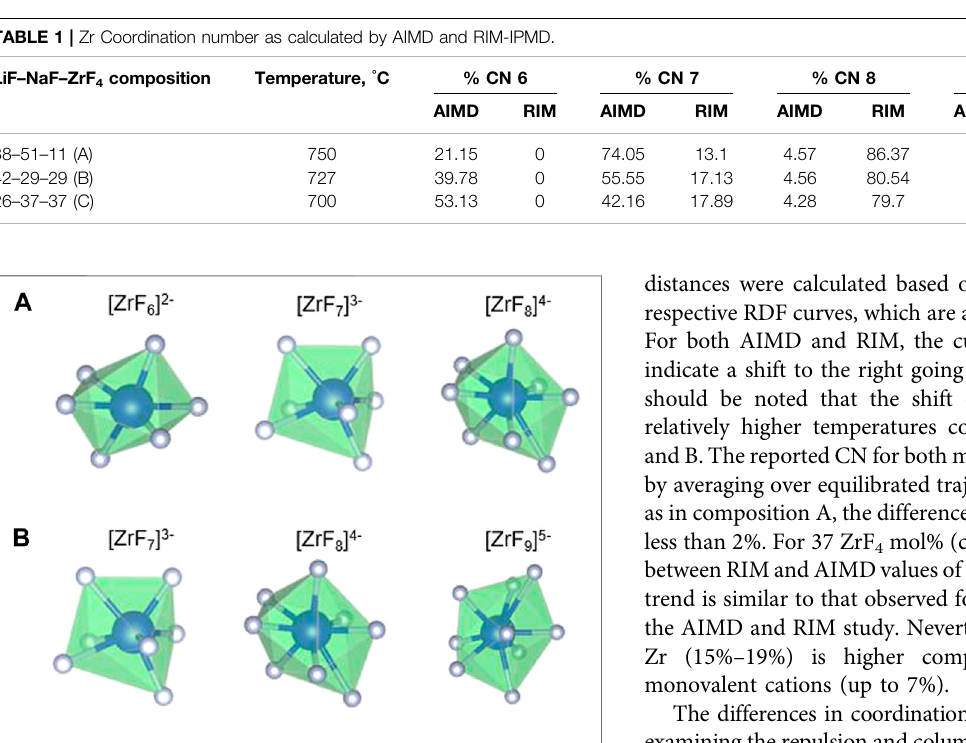
FIGURE 2 | Fluorine zirconium complexes observed in (A) AIMD- simulated and (B) RIM-IPMD-simulated LiF – NaF – ZrF 4 salt compositions.